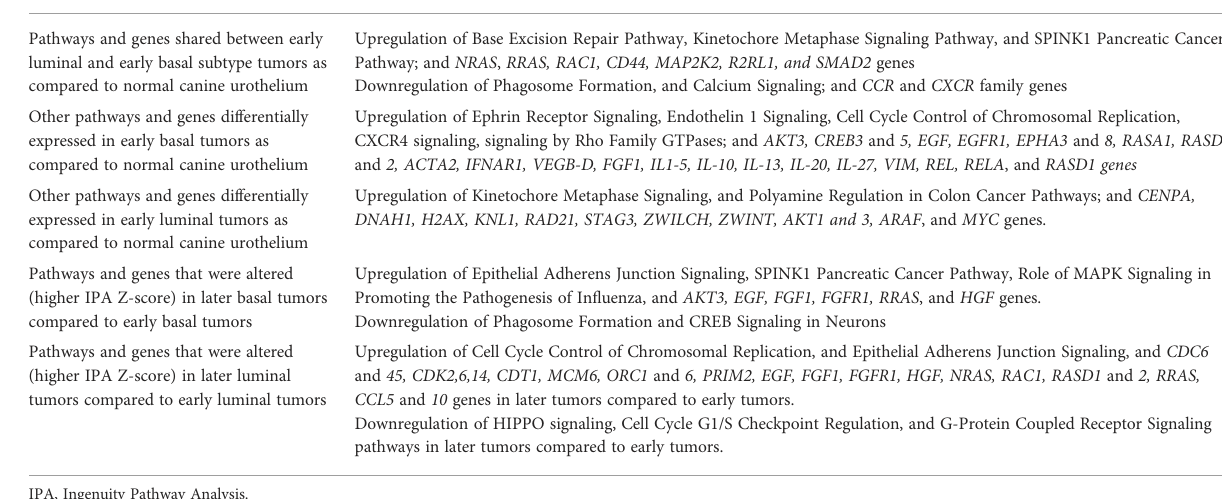
TABLE 2 Results of Ingenuity Pathway Analysis (IPA), examples of pathways with a signi fi cant – log p-value (> 1.3) and a Z score of ≥ 1.5.